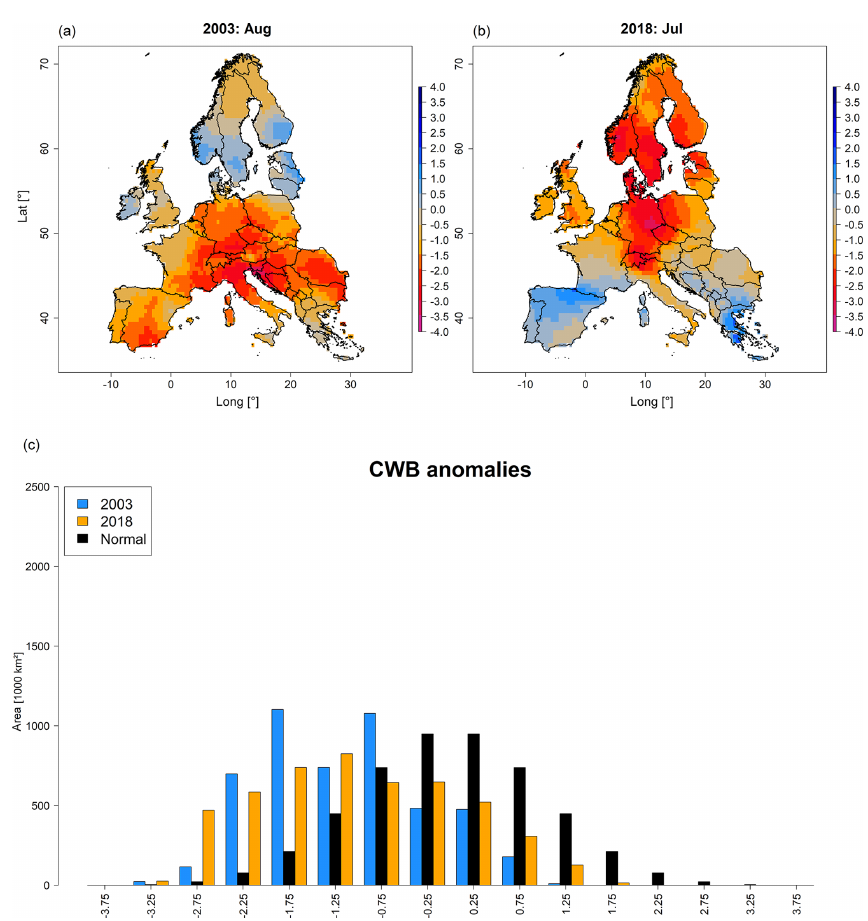
Figure 3. Maps depicting standardized anomalies of climatic water balance for August 2003 and July 2018 (a, b) as well as corresponding area histograms (in units of thousands of square kilometres) for 2003 (blue) and 2018 (orange), compared to a normal distribution (black) (c) . Shades of blue in (a) and (b) indicate relatively moist conditions, whereas shades of red indicate drier conditions in comparison to the 1981– 2018 mean. Time series depicting the temporal development of CWB anomalies for northern, central, and southern Europe are shown in Fig. S5. A video depicting the spatio-temporal development of CWB anomalies from January through October is provided in Video V2